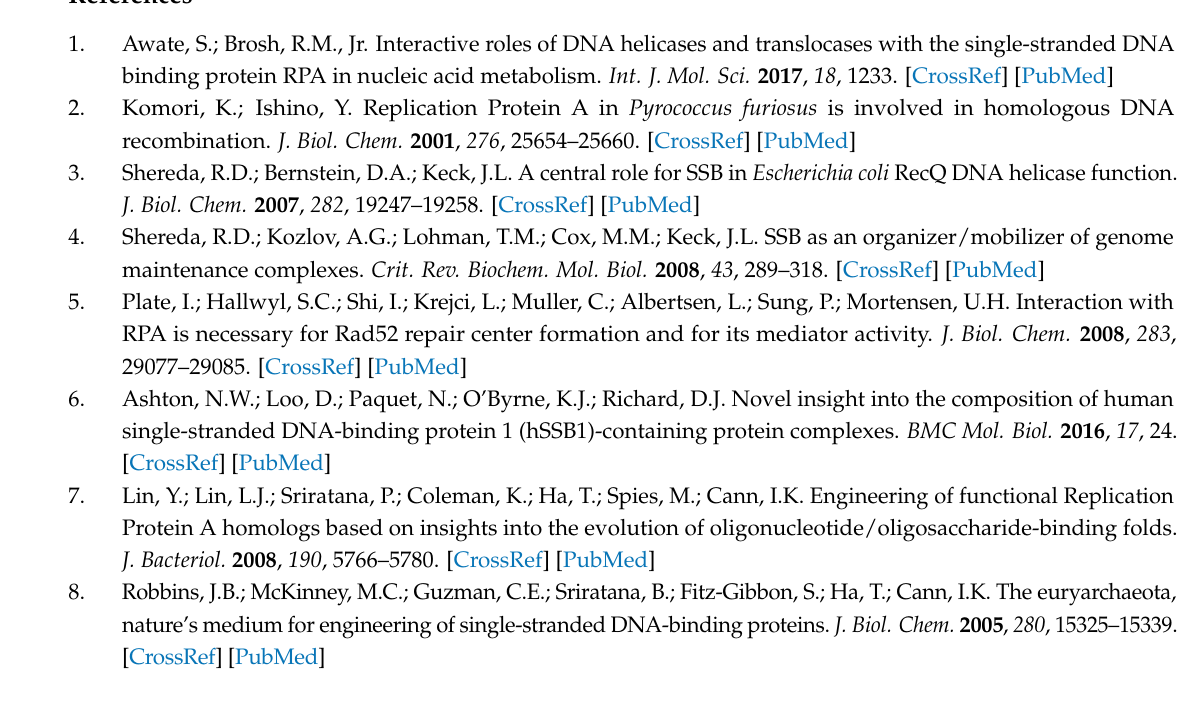
Figure S1: Verification of deletion of rfa2 in LH154, Figure S2: Survival of additional Hbt.salinarum deletion strains to UV-C damage, Table S1: Primers used for deletion creation and verification, Table S2: Transcript primers used for transcript visualization of the rfa2 operon. Table S3: qPCR primers and Taqman™ probes used in this